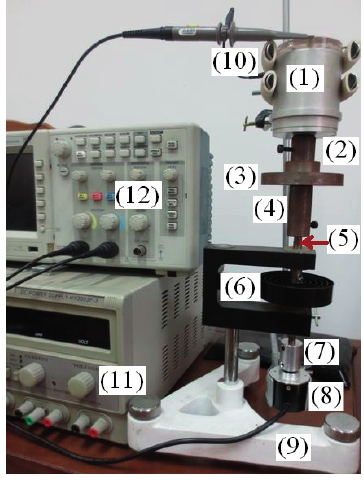
Figure 15. The calibration devices of angular acceleration